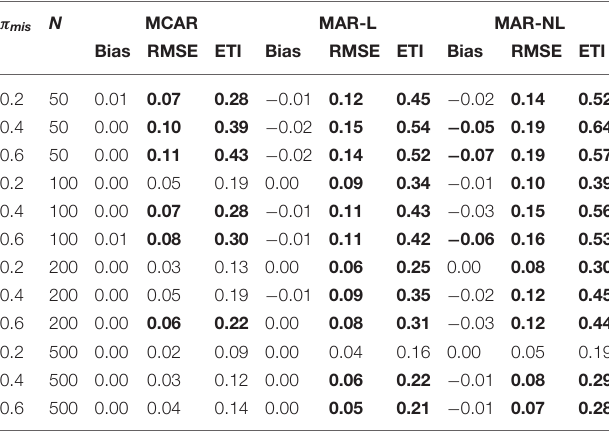
TABLE 1 | The population FMIs. Model